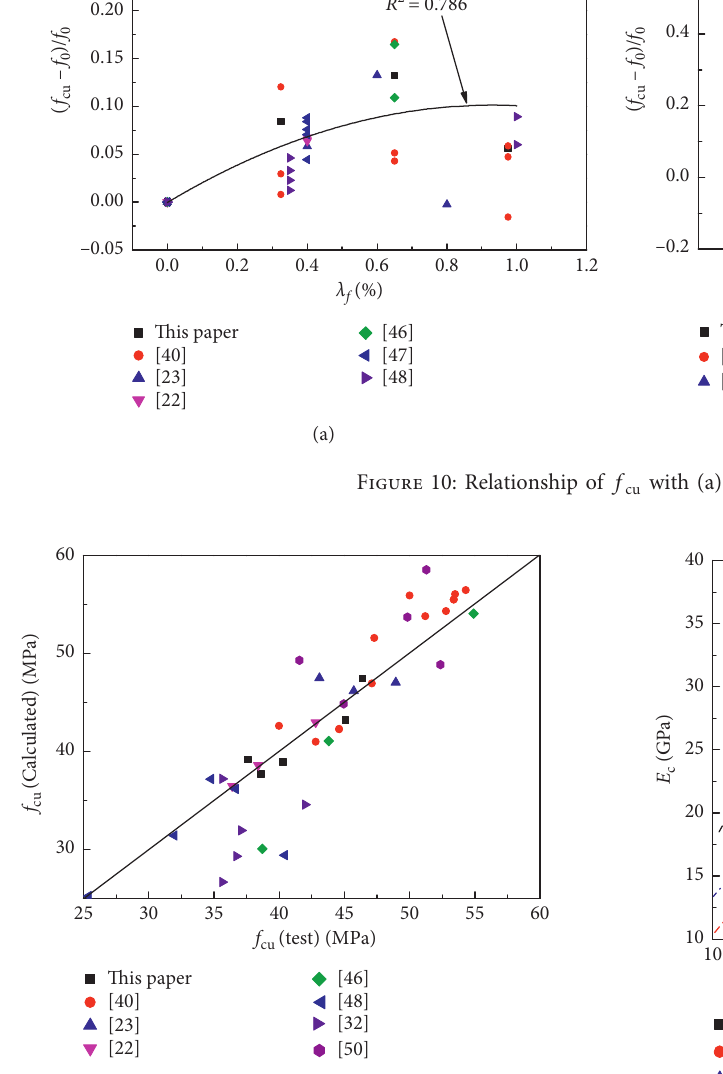
Figure 11: Comparison of f